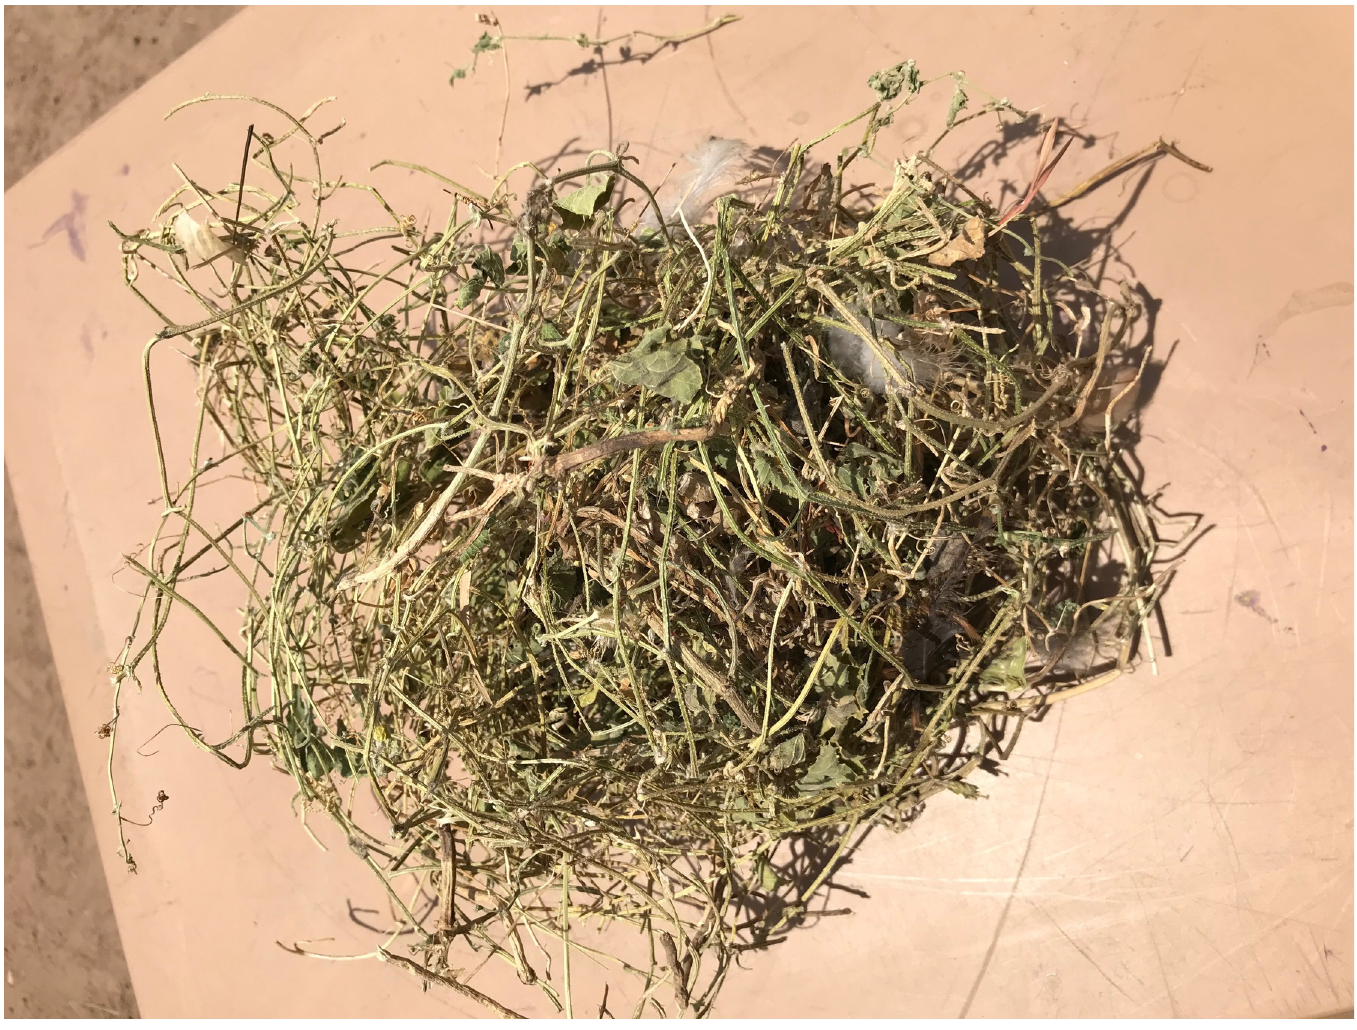
Fig 3. Herbs used in the treatment of